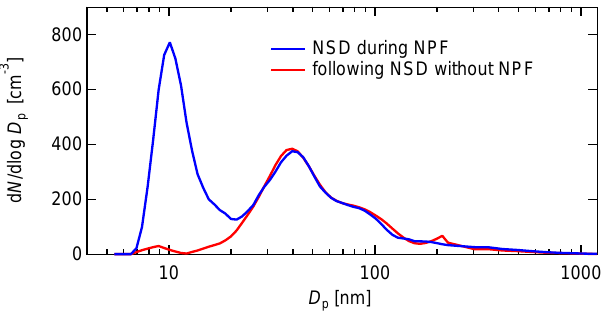
Figure 3. Number size distributions (NSD) measured on 23 April 2011, starting at SOD 52924 (cf. Fig. 2c).